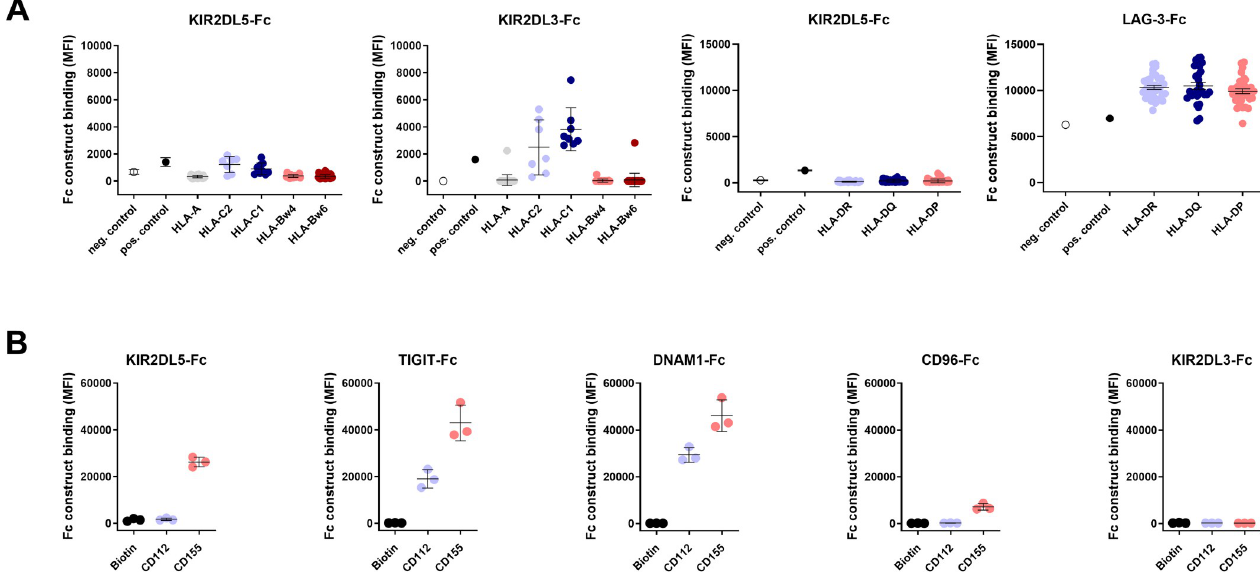
Fig 1. Binding of KIR-, TIGIT-, DNAM-1- and CD96-Fc constructs to HLA class I-, HLA class II- and nectin(-like)-coated beads. (A) KIR2DL5-Fc construct binding to HLA class I-coated and HLA class II-coated beads was measured by using a PE-labeled anti-IgG antibody and is shown as median fluorescence intensity (MFI). Each dot represents an individual HLA class I or class II allotype. Binding of KIR2DL5-Fc constructs was assessed in triplicates ( n = 3). MFIs are shown as mean values for each HLA allotype. The 97 HLA class I allotypes as well as the 95 HLA class II allotypes were grouped according to the different subsets HLA-A, HLA-C1, HLA-C2, HLA-Bw4, HLA-Bw6 (HLA class I) and HLA-DR, HLA-DQ, HLA-DP (HLA class II). Negative control beads (white) were not coated with HLA antigen, positive control beads (black) were coated with purified human IgG. Black bars represent the mean of each HLA group and error bars show the standard deviation. (B) NK cell receptor Fc construct binding to CD112 (Nectin-2) and CD155 (PVR) was measured by flow cytometry. Binding of KIR2DL3, KIR2DL5, TIGIT, DNAM-1 and CD96 to biotin (neg. control), CD112 and CD155 was assessed as MFI in three independent experiments ( n = 3). The mean values of the experiments are shown as black bars and standard deviations are depicted as error bars.